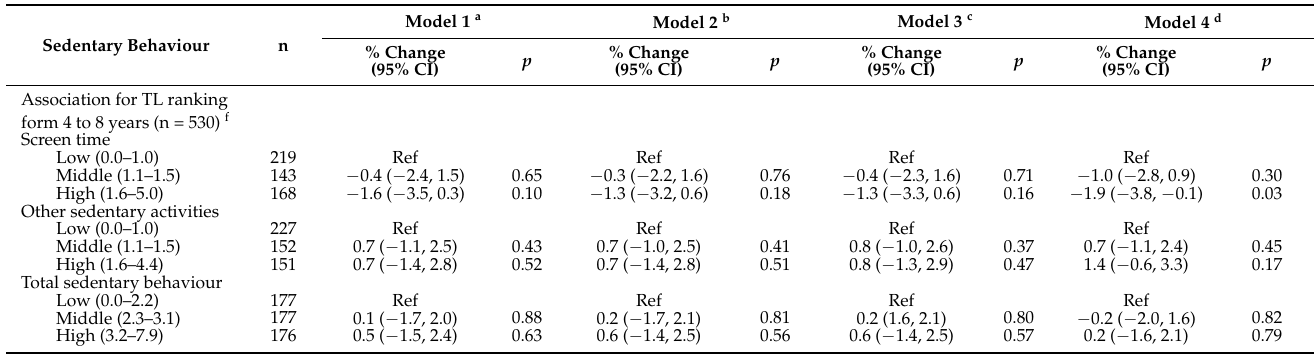
a Model 1: model adjusted for blood storage date and cohort (Asturias, Gipuzkoa, and Sabadell); b Model 2: Model 1+ additional adjustment for child’s total energy intake (kcal./day), ultra-processed food intake (g/day), and age at baseline (years). c Model 3: Model 2+ additional adjustment for child’s sex (male or female). d Model 4: Model 3+ additional adjustment for follow-up time (years) and baseline leucocyte telomere length. e The associations